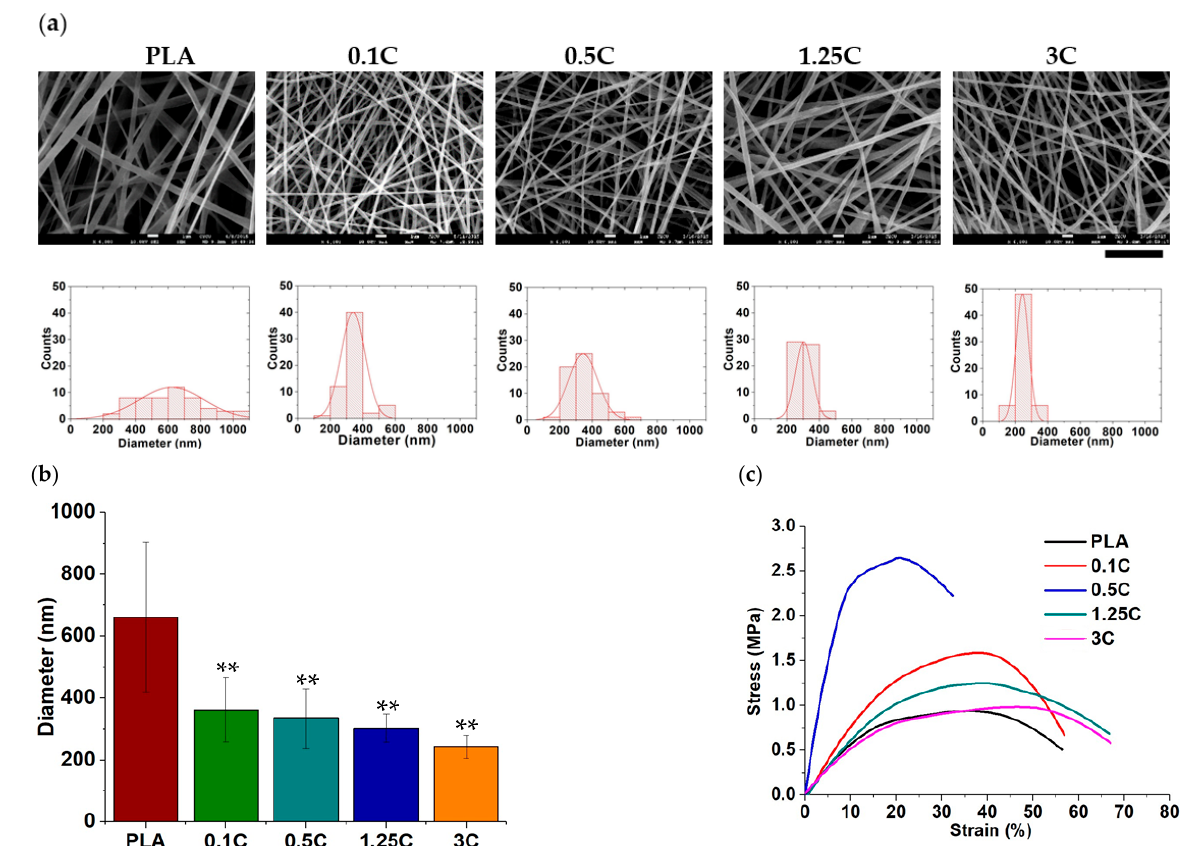
Figure 1. Characteristics of MWCNT-containing PLA nanofibers. ( a ) The morphology and size distribution of nanofibers were examined by SEM analysis. (scale bar = 5 µ m); ( b ) the average size of MWCNT-containing nanofibers. (**: p < 0.01 compared to the pristine PLA group); ( c ) mechanical performances of nanofibers were evaluated by a tensile test. Table 1. Mechanical performances of MWCNT-containing